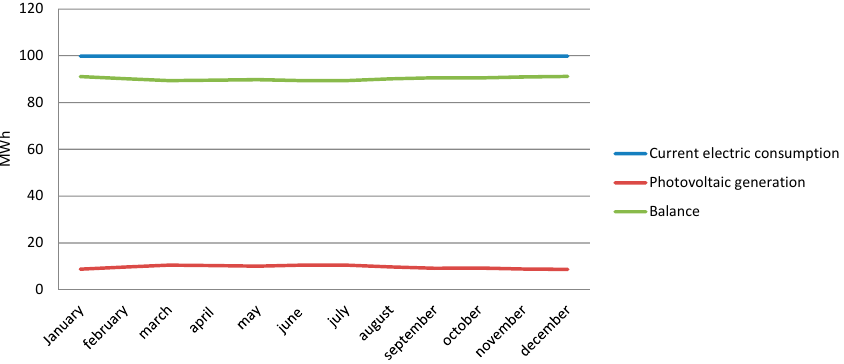
Figure 3. Electric consumption and annual photovoltaic generation in the COD of